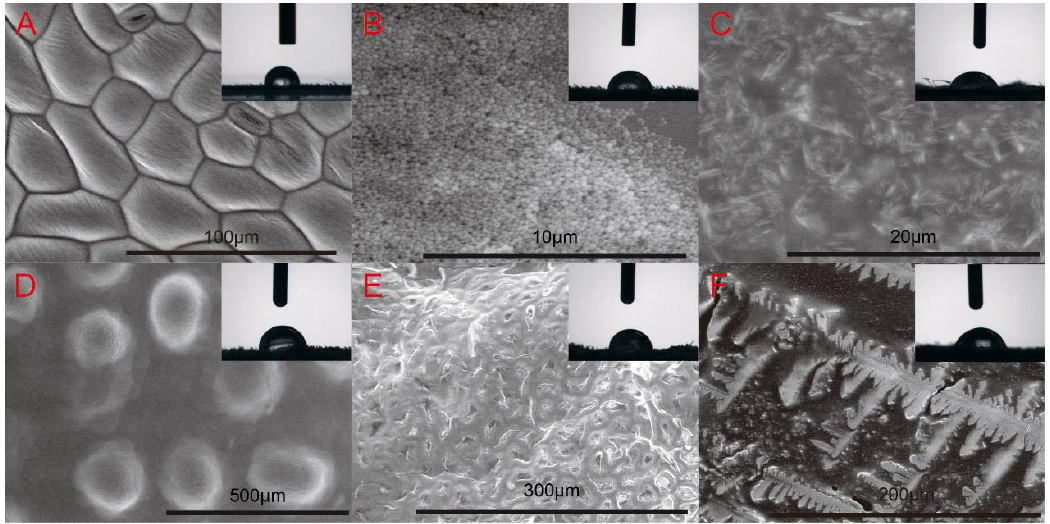
Figure 6. Foliar spread and contact angle of different pesticide formulations on cucumber leaves ( A ) blank control; ( B ) dual-functionalized pesticide nanocapsules; ( C ) VTSC; ( D ) TSC; ( E ) VAS; ( F ) VWP.